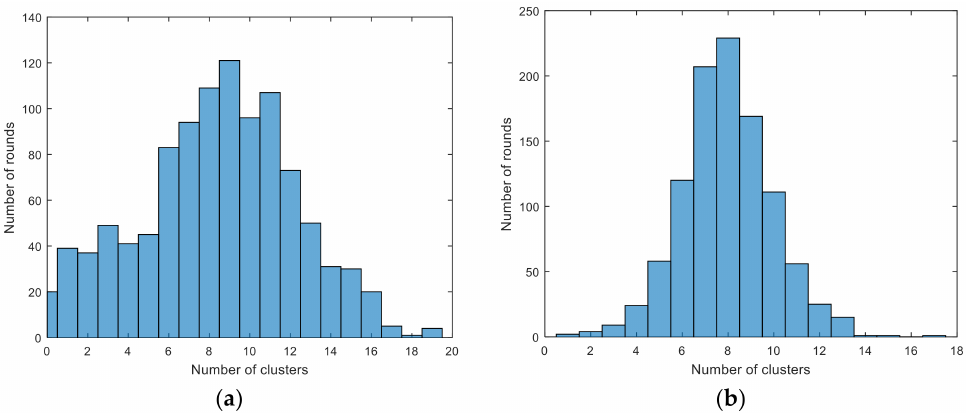
Figure 5. Distributions of the number of cluster heads in CFSFDP-E and LEACH. ( a ) distribution of the number cluster heads in CFSFDP-E. ( b ) distribution of the number of cluster heads in LEACH.